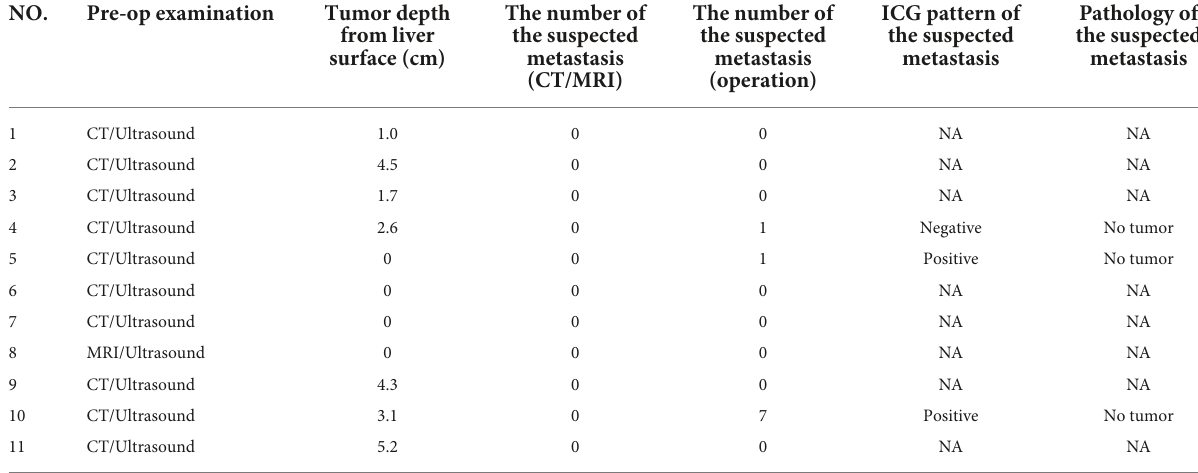
TABLE 3 Comparison of preoperative imaging with intraoperative fluorescence imaging. NO.